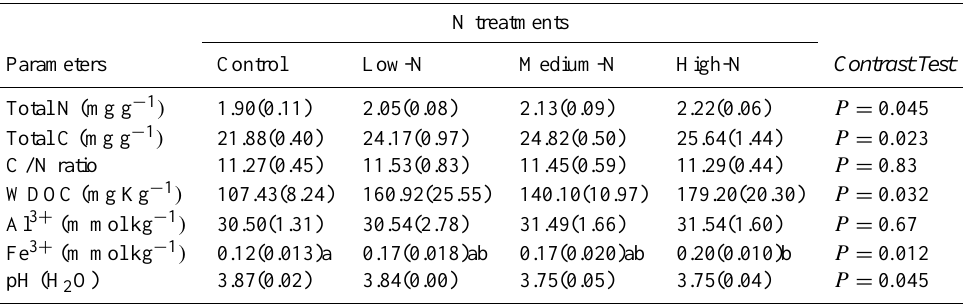
Table 2. Responses of soil chemistry in the primary rooting zones (0–20cm soils) to N addition in the lowland tropical forest of Southern China in August, 2009. The different lowercase letters indicate significant differences at P < 0 . 05 level, and no letters indicate no significant differences among N treatment levels, respectively (Tukey’s HSD test). Contrast Test is conducted between N treatments and the Controls using planned contrast analysis.